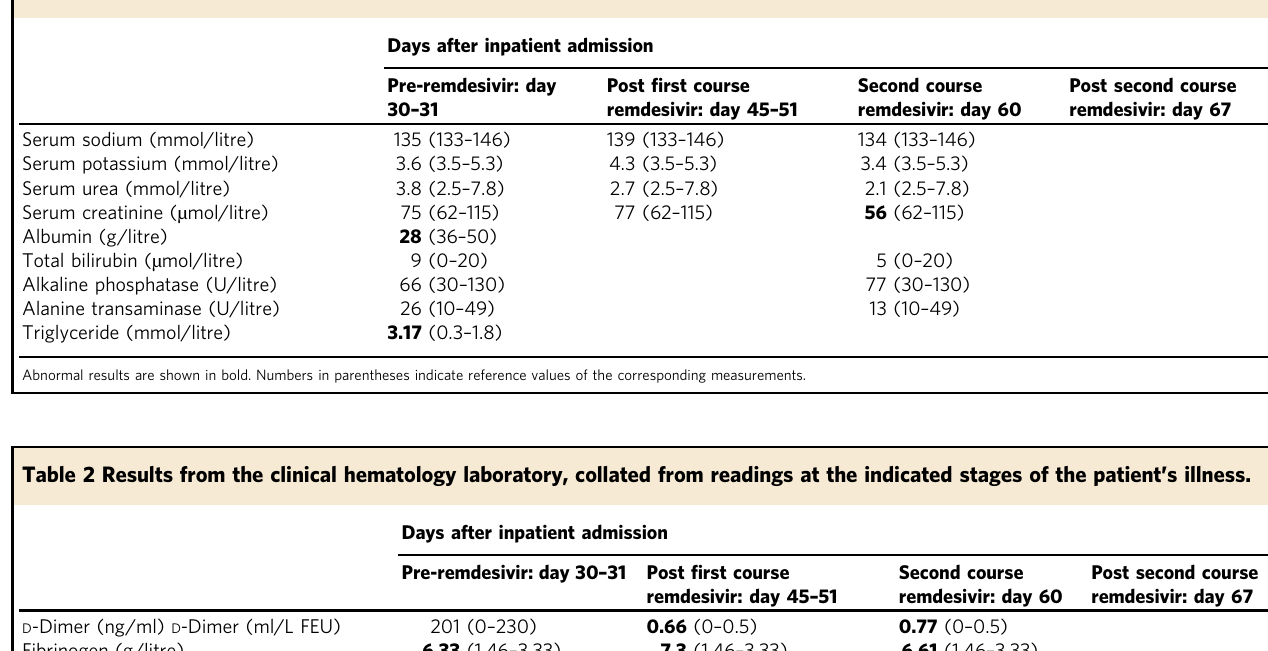
Table 1 Results from the clinical biochemistry laboratory, collated from readings at the indicated stages of the patient ’ s illness.